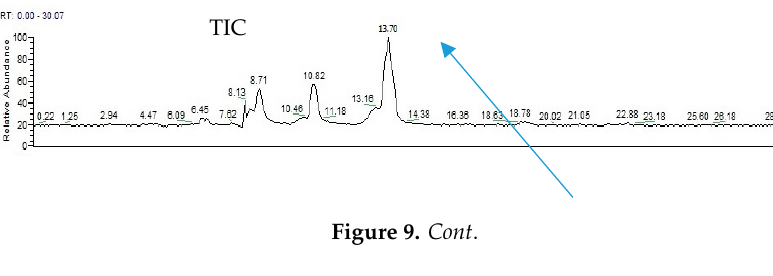
Figure 8. ( a ) HPLC chromatograms of synthetic cordycepin as standard, ( b ) HPLC chromatograms of cordycepin in the CM4 fraction compared with the standard (0.5 mg / mL).